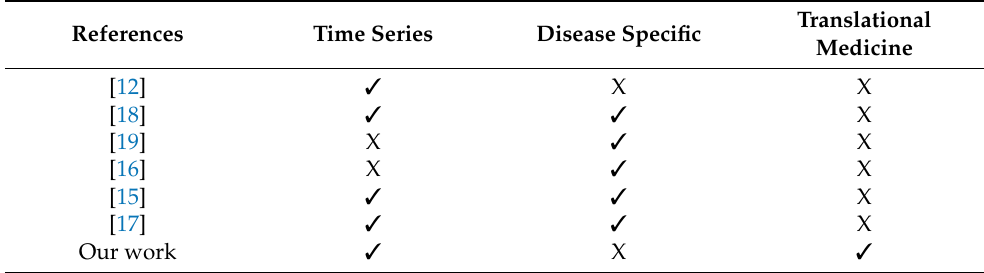
Table 1. Comparison with earlier